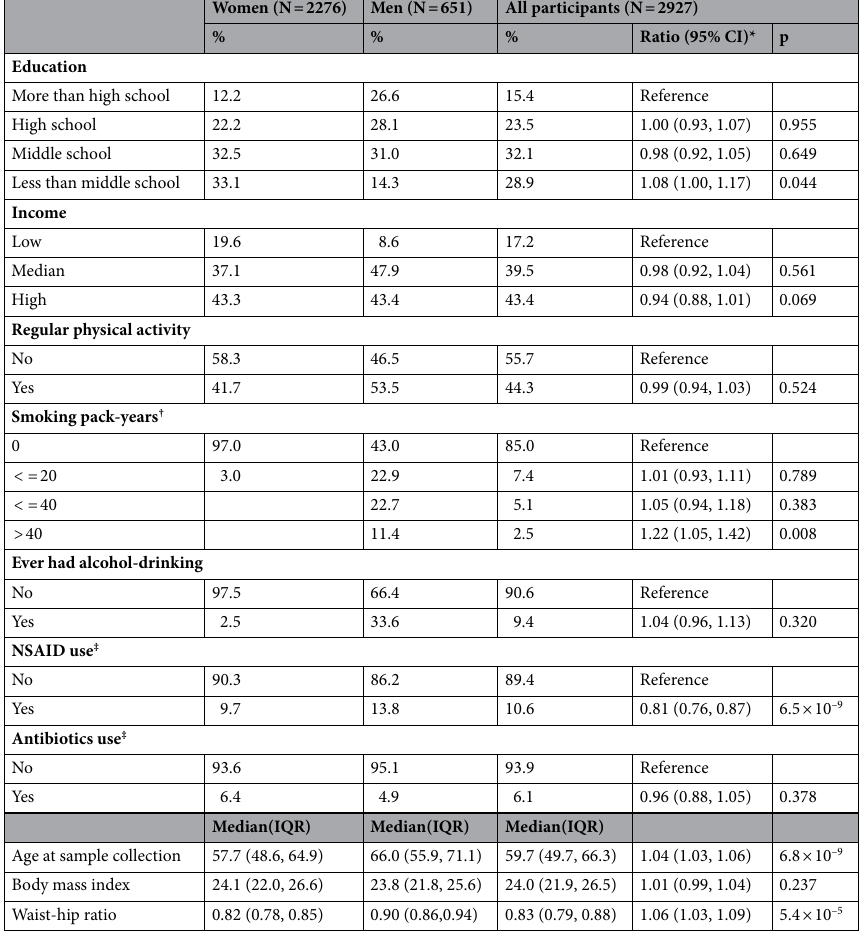
Table 1. Frequency distributions of selected participants’ characteristics and their associations with urinary PGE-M levels. IQR interquartile range. *Ratio of geometric means with mutual adjustment for all variables listed in the table. It was estimated as compared with the reference group for categorical variables, or for each 5-year increment for age at sample collection, or for each standard deviation increment for BMI and WHR. † For women, smoking pack-years were defined as 0 or > 0. ‡ Ever used NSAID or antibiotics one week before urinary sample